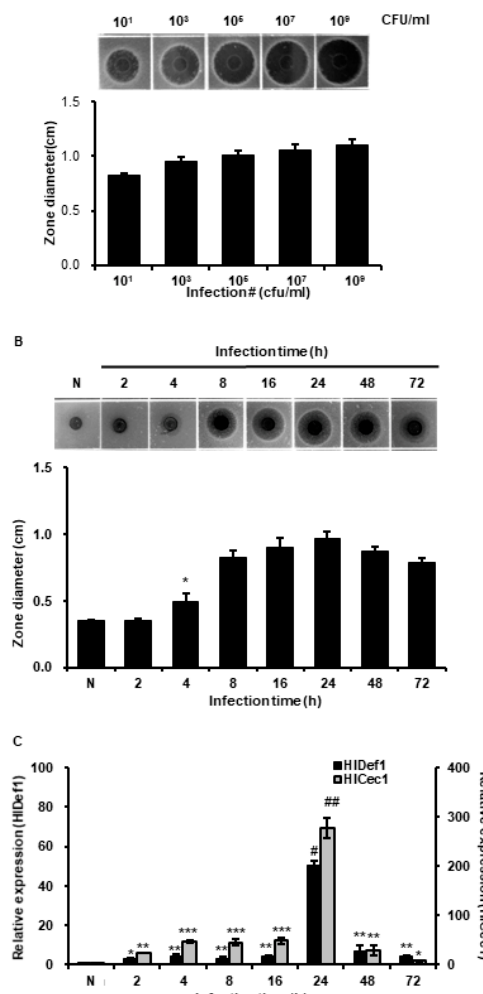
Figure 2. Determination of optimal conditions to produce L. casei -immunized H. illucens larvae (HIL) with highest antimicrobial activity. ( A ) Evaluation of antimicrobial activities at di ff erent L. casei concentrations. We infected HIL with 10 1 to 10 9 cfu / mL of L. casei to determine the optimal concentration for the mass production of AMPs. The activity in L. casei -immunized HIL hemolymph increased in a concentration-dependent manner. The values of column graphs are presented as the mean ± S.D. ( B ) Evaluation of antimicrobial activities at di ff erent incubation times after L. casei infection. Highest hemolymph activity of L. casei -immunized HIL occurred at 24 h. ( C ) Assessment of HiCec1 and HiDef1 mRNA expressions. HiCec1 and HiDef1 gene expressions in L. casei -immunized HIL hemolymph were evaluated at 2, 4, 8, 16, 24, 48 and 72 h after infection. ( A , B ) Radial di ff usion assay (RDA) was performed with E. coli . ( B , C ) The values of column graphs are presented as the mean ± S.D. *, **, ***, # and ## indicate p < 0.05, p < 0.01, p < 0.005, p < 0.001 and p < 0.00001 vs. normal control (N),